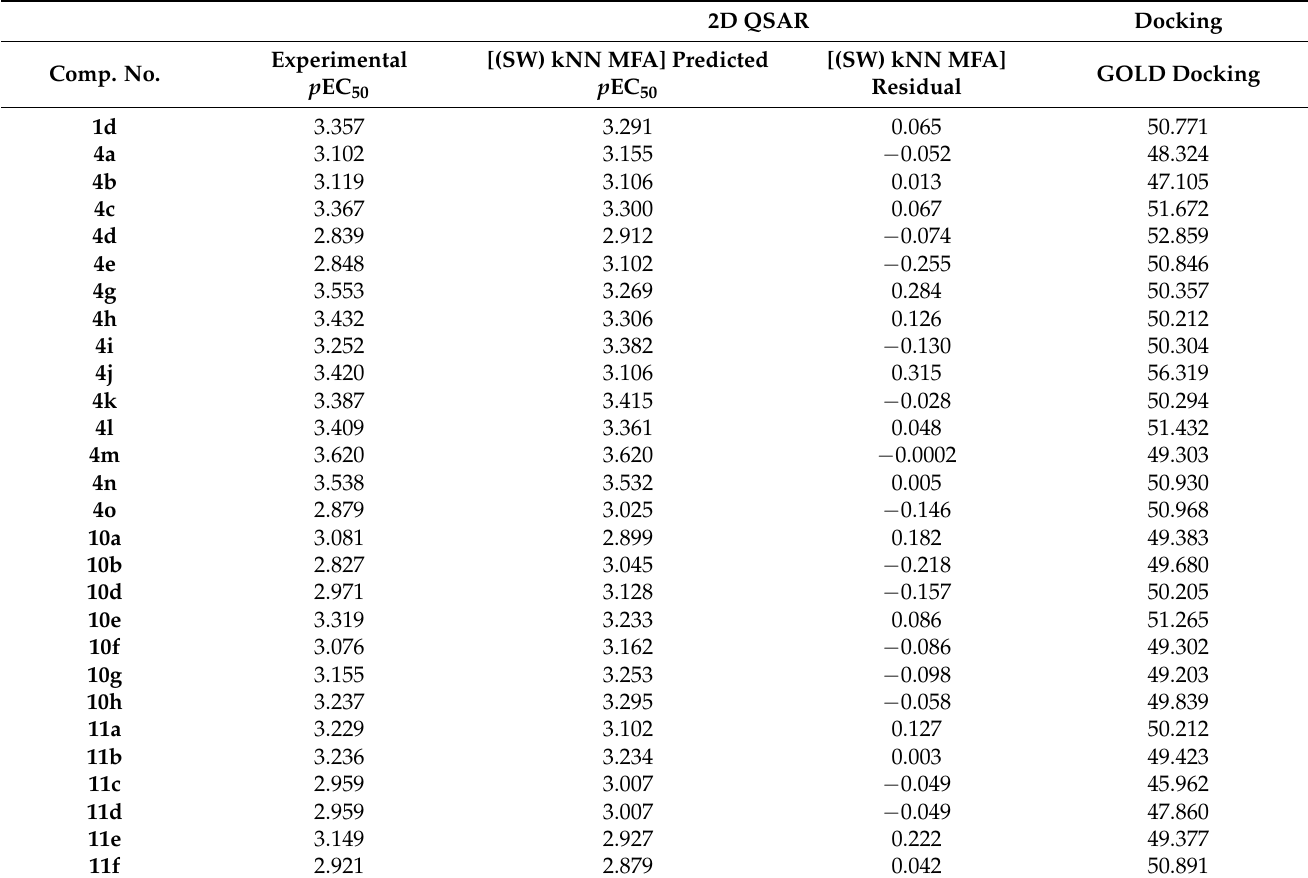
Table 4. Experimental, predicted and residual activities of the compounds obtained in 2D QSAR and GOLD score.